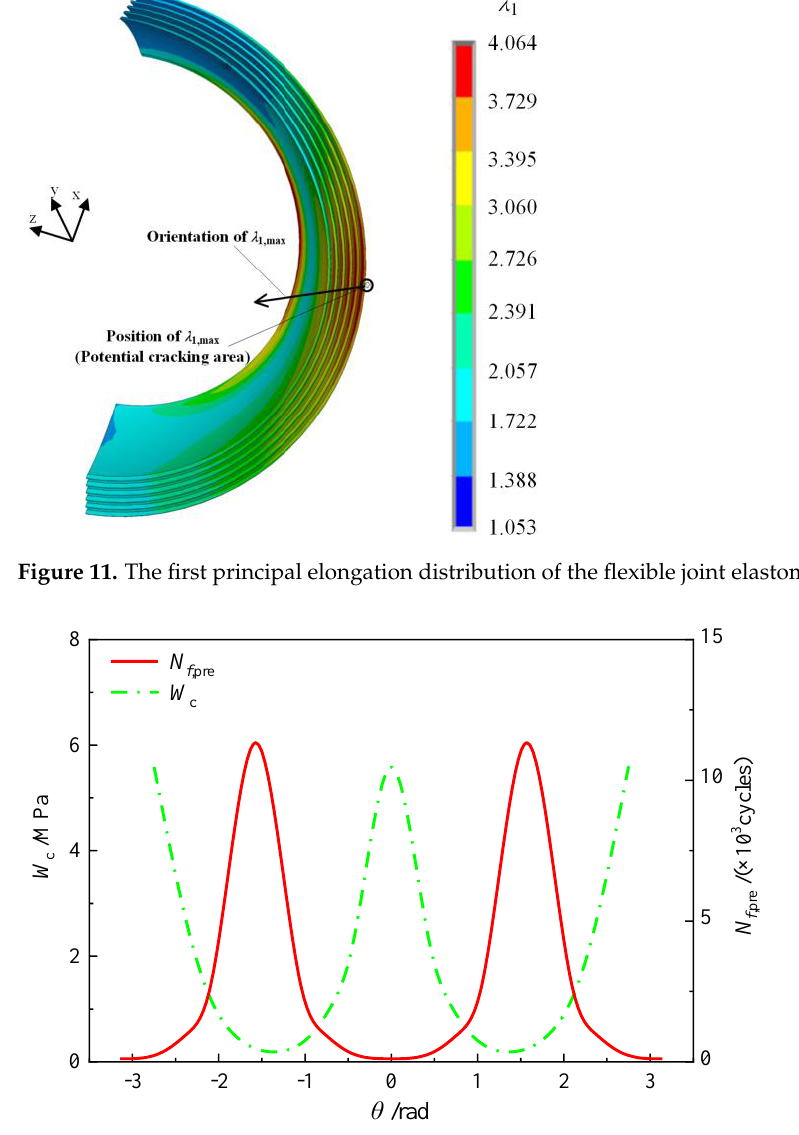
Figure 12. CED and N f ,pre distribution in different plane at the danger point of elastomer.